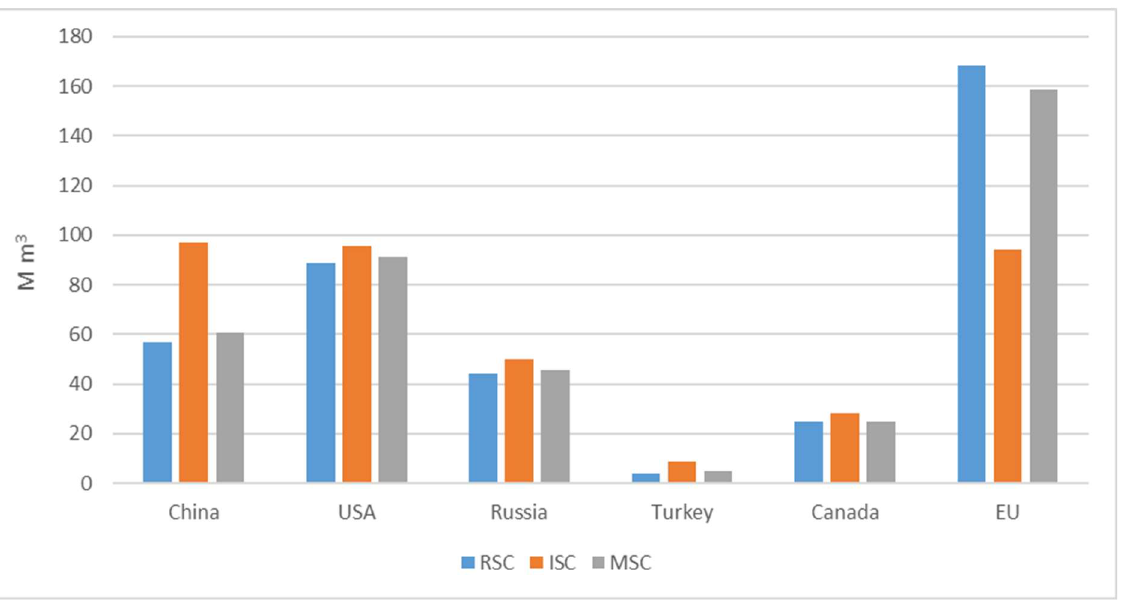
Figure 7. Sawnwood production of the countries with the greatest changes (ranking of countries is according to changes in ISC vs. RSC) and the EU: RSC (blue), ISC (orange) and MSC (grey) in 2050 [authors’ results].